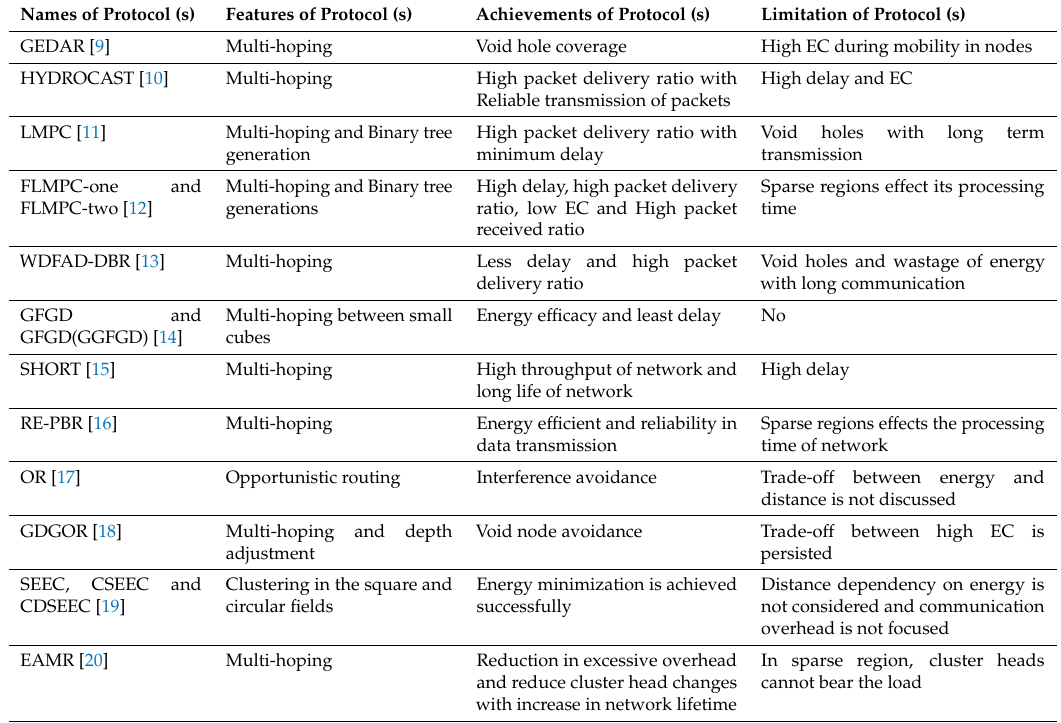
Table 3. Summarized Literature